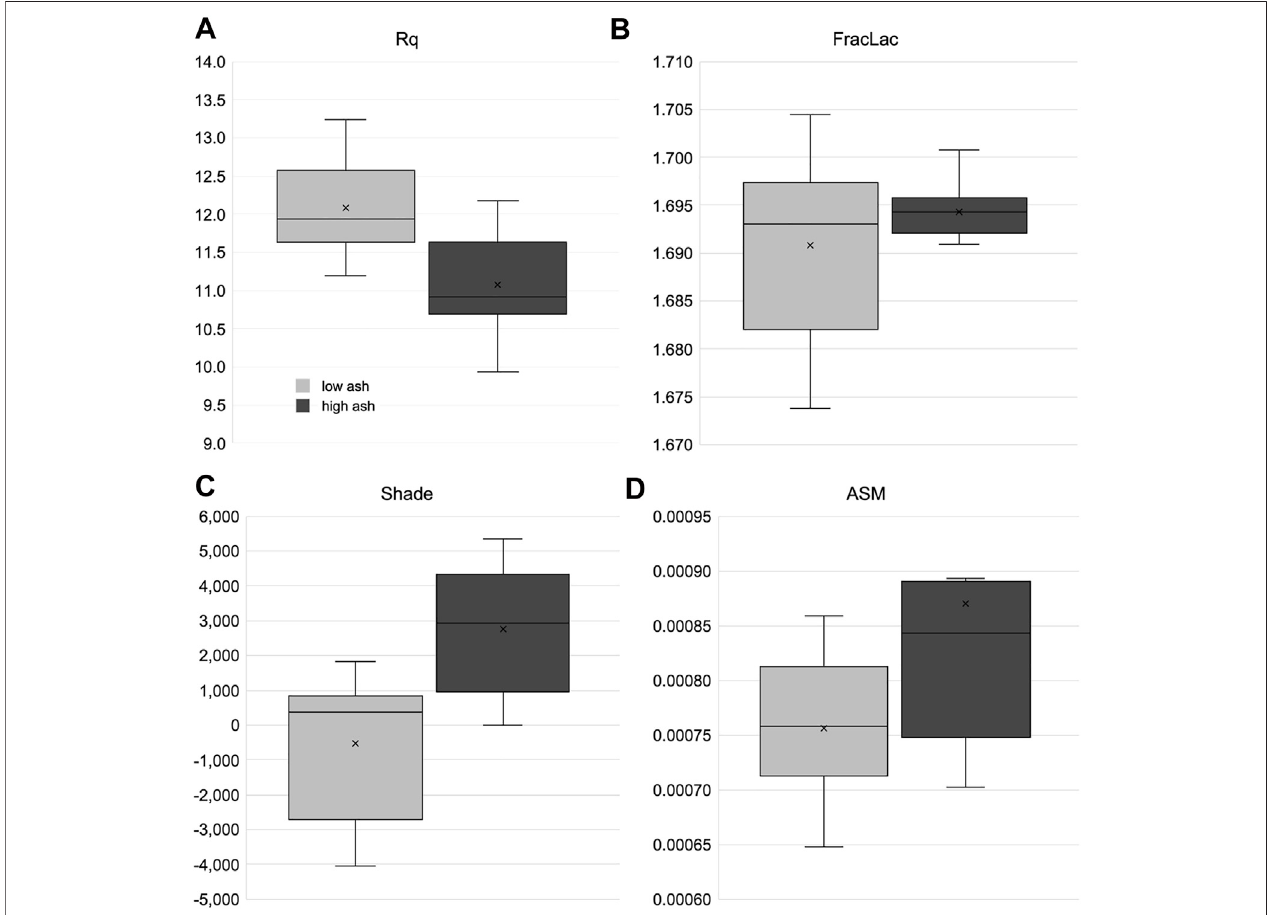
FIGURE 9 | A subset of textural feature image analysis results from bale core samples taken corn stover bales with variable ash content. (A) Rq is the root mean square deviation. (B) FracLac is the local connected fractal dimension. (C,D) Shade and angular second moment (ASM) are grey-level co-occurrence matrix analysis